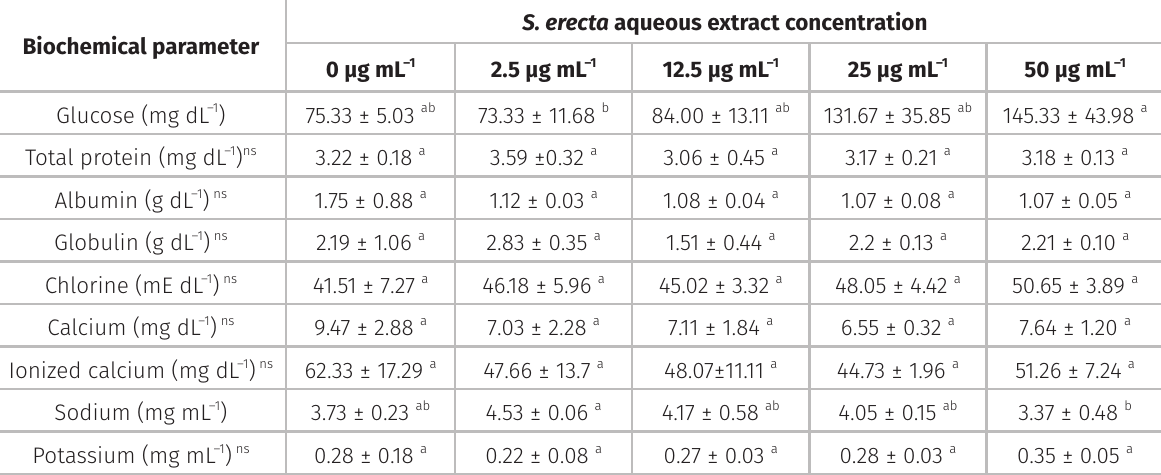
Table II. Plasma biochemical parameters in Piaractus mesopotamicus exposed to different concentrations of Serjania erecta aqueous extract for 4 h.